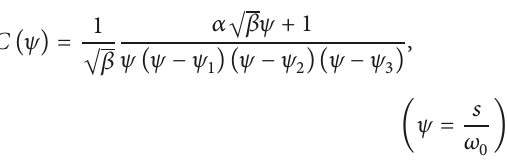
Figure 15: Nyquist diagram ( 𝛼 = 3 ).